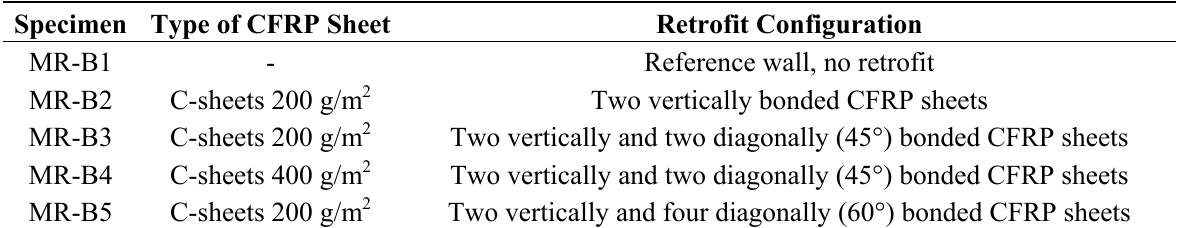
Table 3. Tested configurations of retrofitted masonry walls in Series